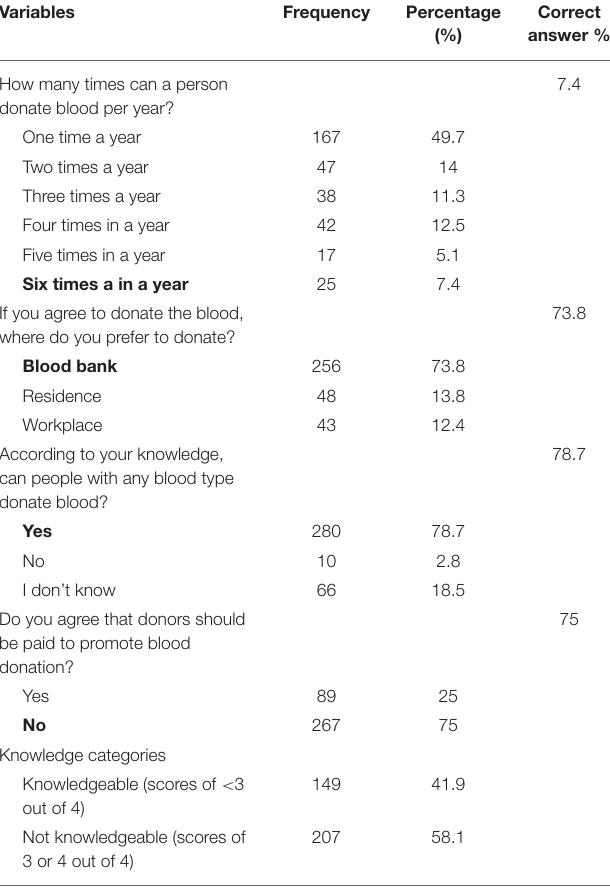
TABLE 3 | Knowledge and motivations about blood donation ( n = 356). Variables